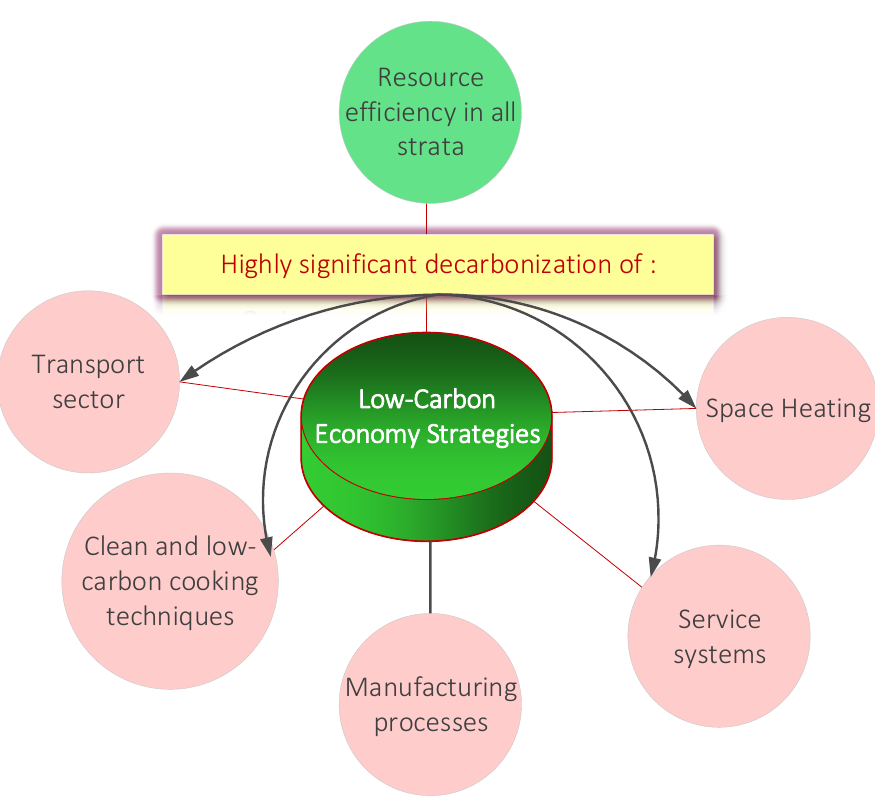
Figure 5. Strategies for low -carbon